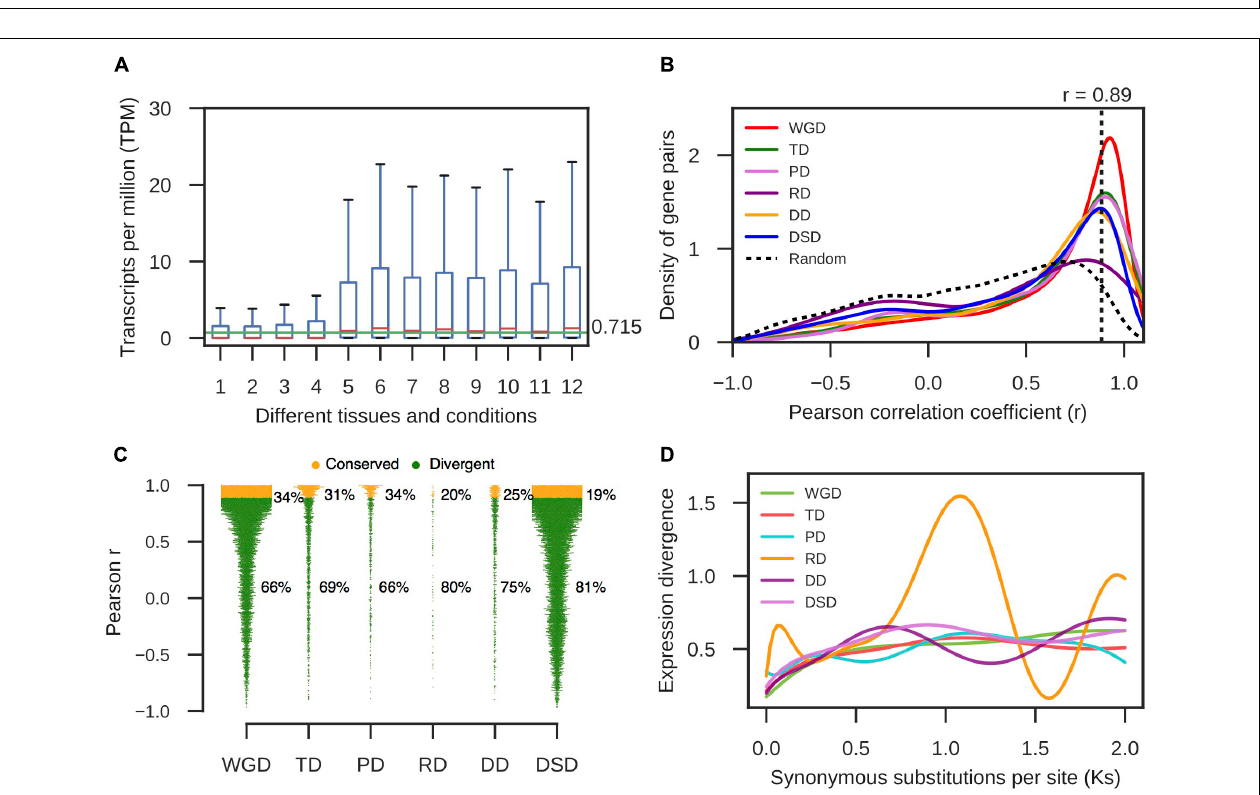
FIGURE 3 | The characteristic of duplicated genes that experienced positive selection. (A) The proportion of duplicated gene pairs under different selection pressure. Green dot: positive selection; red dot: neutral selection; blue dot: negative selection. (B) GO analysis of duplicated genes that experienced positive selection. The larger circle indicates a higher frequency of occurrence of a GO term.